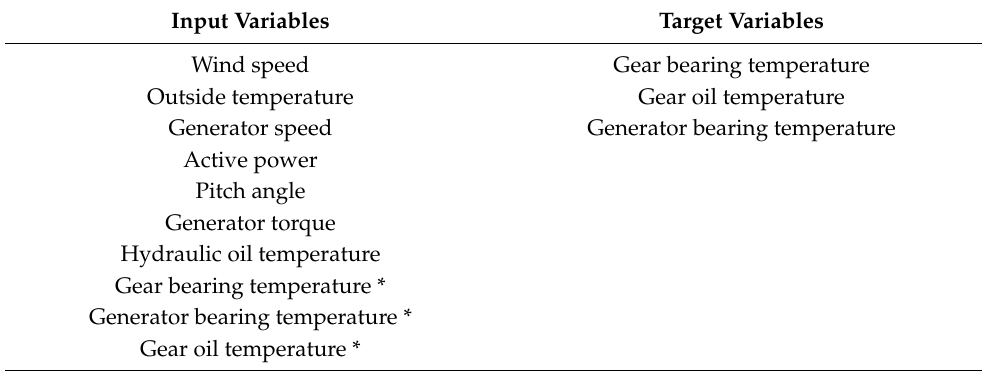
Table 3. Model input and output variables for temperature prediction. Variables with an asterisk are removed as an input when that variable is the target